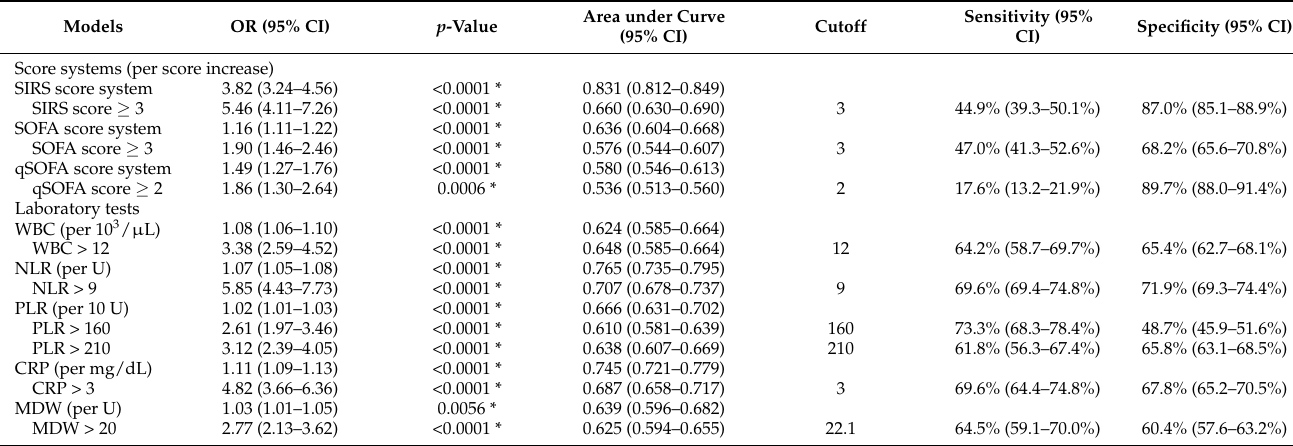
Table 2. Primary Outcome: The Scoring Systems and Laboratory Tests for Predicting Sepsis